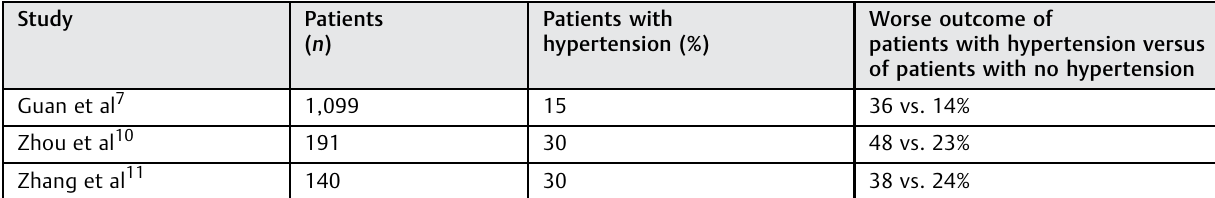
Table 3 Frequency of hypertension in COVID-91 patients and clinical outcome Study